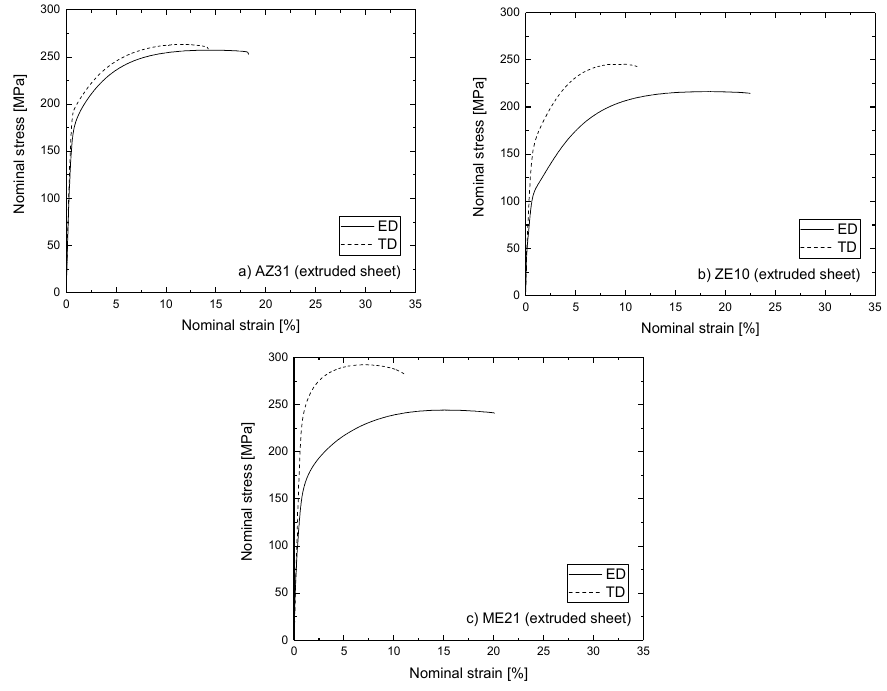
Figure 4. Stress–strain diagrams in the RD and the TD for the extruded magnesium sheets; ( a ) AZ31; ( b ) ZE10; ( c ) ME21.